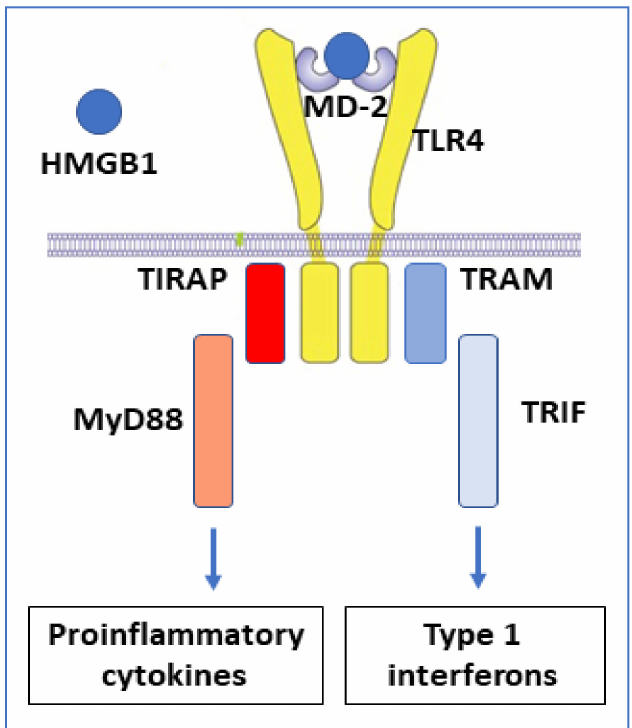
Figure 3. Disulfide HMGB1 binds to MD-2 and activates the TLR4 receptor complex via two separate intracellular signal pathways. Proinflammatory cytokines are formed when the adapter molecule TIRAP gets associated with toll-like receptor 4 and the myeloid differentiation factor 88 (MyD88) that activates the NF- κ B signaling pathway. Interferon- β is produced when TRAM (TRIF-related adaptor molecule) associates with TRIF (TIR-domain-containing adapter-inducing interferon- β